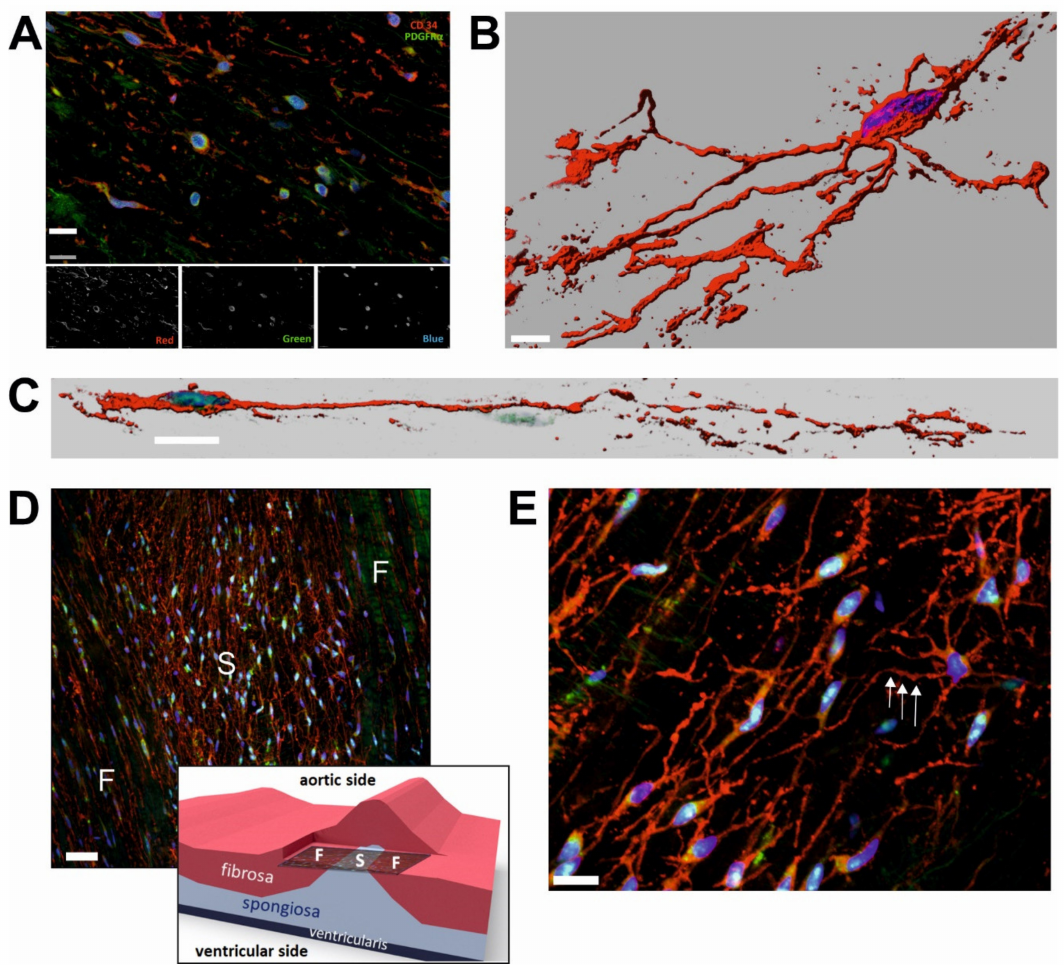
Figure 2. Identification, variability, and spatial organization of CD34 / PDGFR α double positive cells in the human aortic valve. ( A ) Laser scanning confocal microscopy image showing co-localization of CD34 (red) and PDGFR α (green) in selected cells. Grayscale images show signals from the red, green, and blue channels, respectively. ( B , C ). Reconstruction images of two morphologically di ff erent CD34 +/ PDGFR α + cells based on the whole-mount valve specimens imaged by confocal microscopy and subsequently rendered using the Imaris (Bitplane AG, Zürich, Switzerland) software. ( D ) Di ff erences in the spatial organization of CD34 +/ PDGFR α + cells in fibrosa-F, and spongiosa-S. Whole-mount specimen. Imaged cusp area is presented graphically. ( E ) High magnification image showing three-dimentional network of CD34 +/ PDGFR α + cells in spongiosa. Note the moniliform projections (one is arrowed). Whole-mount specimen. Scale bars: 15 µ m ( A ), 10 µ m ( B , C ), 50 µ m ( D ), 20 µ m ( E